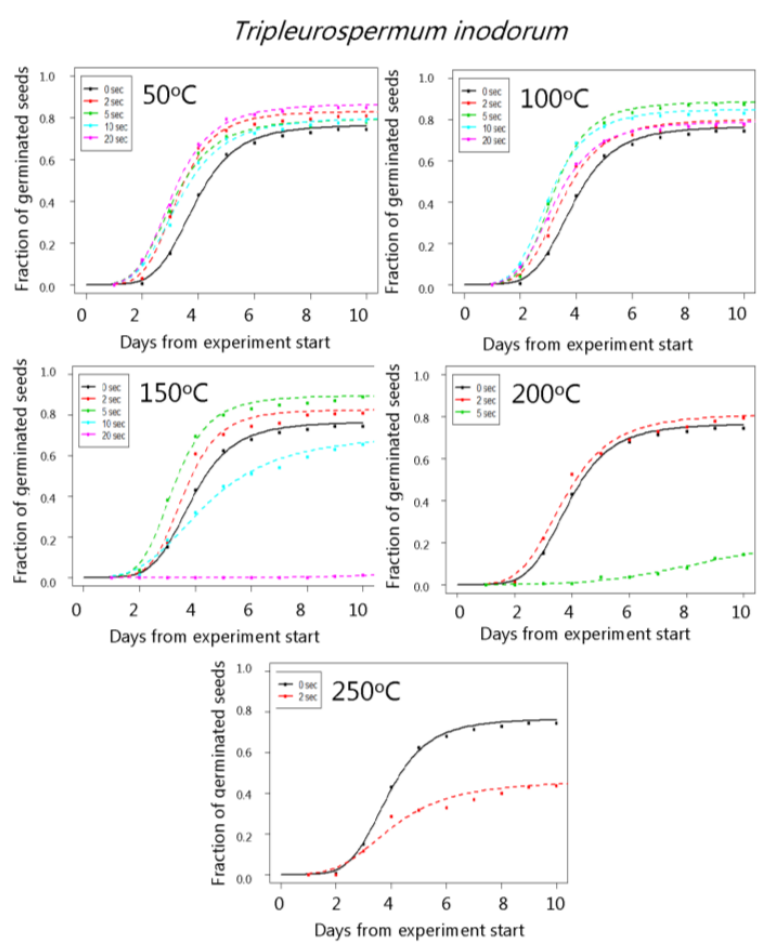
Figure 2. Germination curves of seed lots of the grass weed Alopecurus myosuroides treated with various temperature and durations.